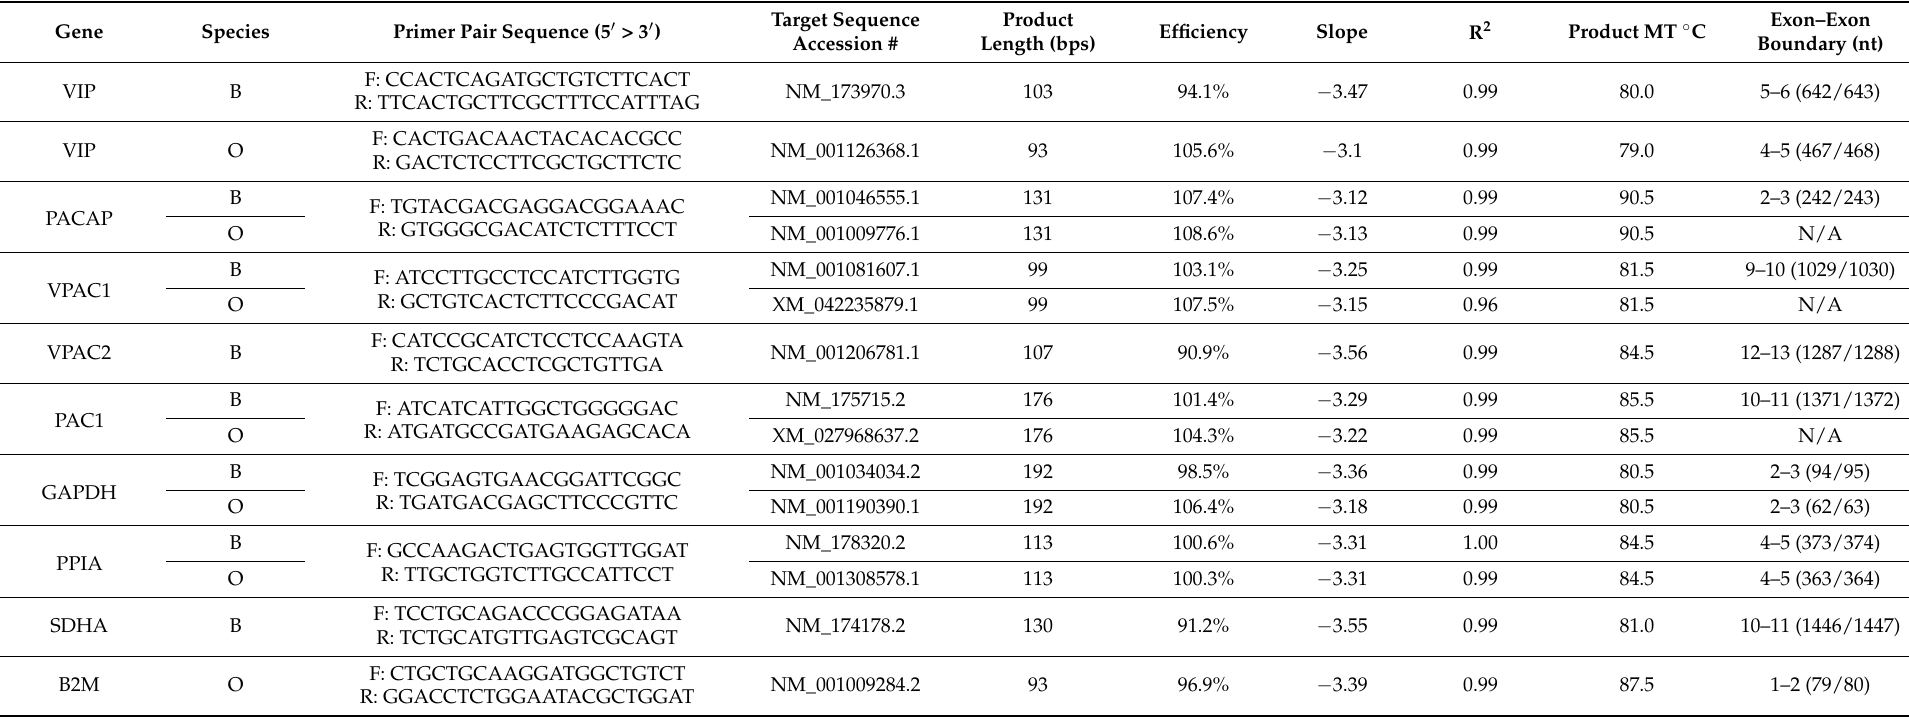
Table 1. Primer Specifics. All primers were designed using NCBI Primer Design [39]. Each row denotes a specific gene, optimized species, F&R primer